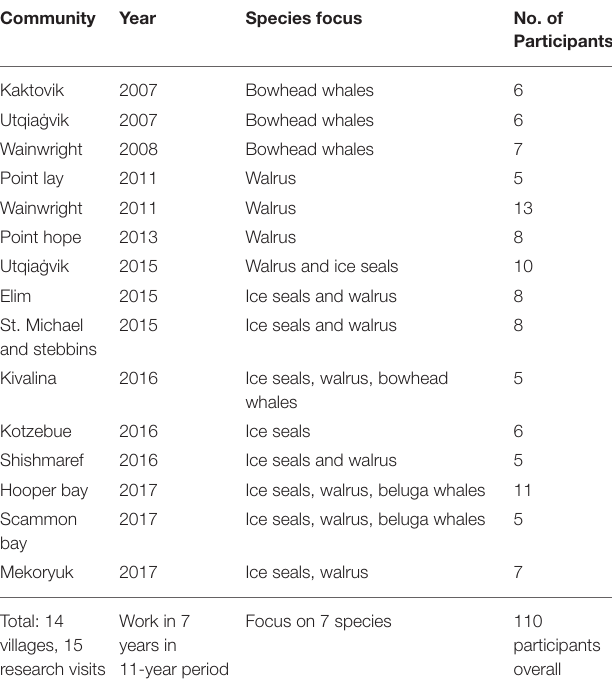
TABLE 1 | Summary of community research